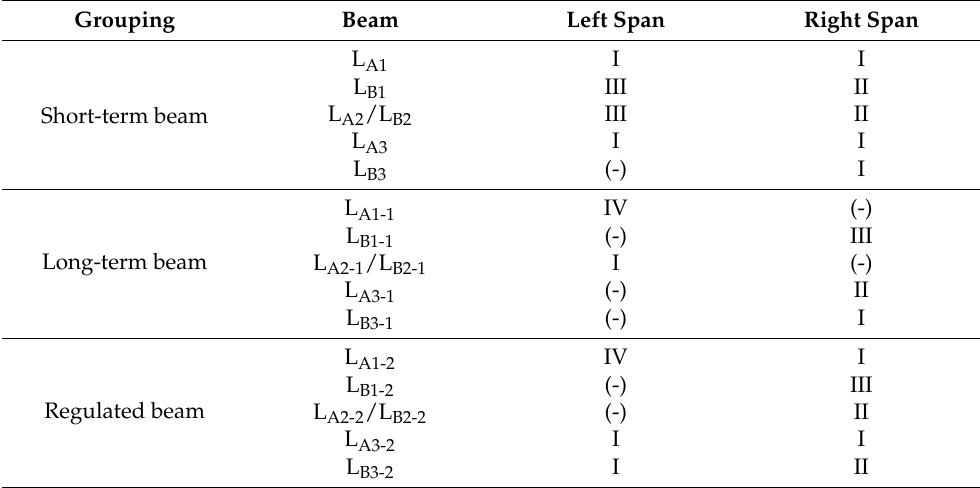
Table 2. Failure mode of glulam continuous beam.